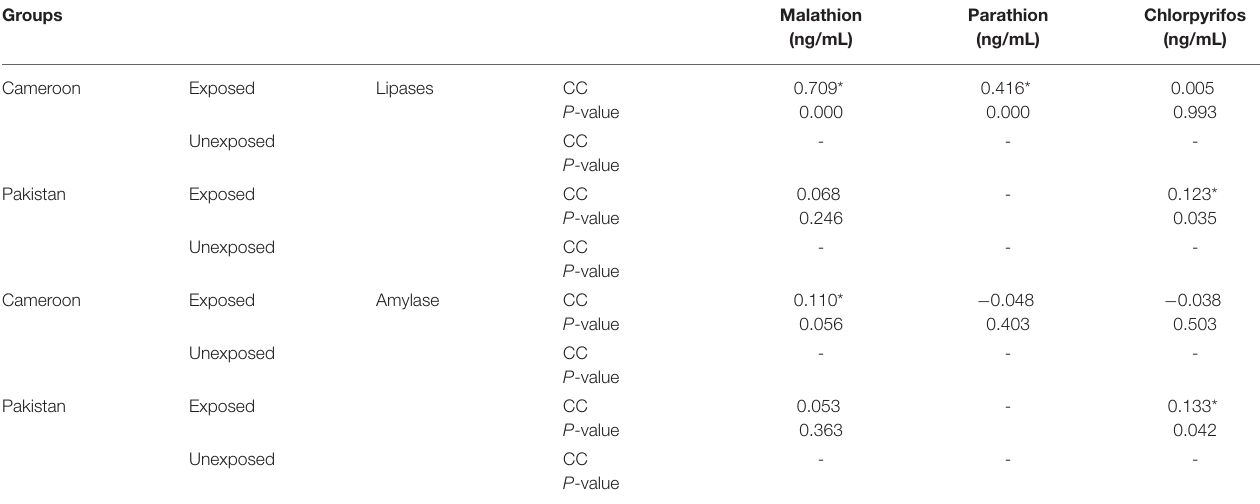
TABLE 4C | Correlation of lipases and amylases with pesticides residues.